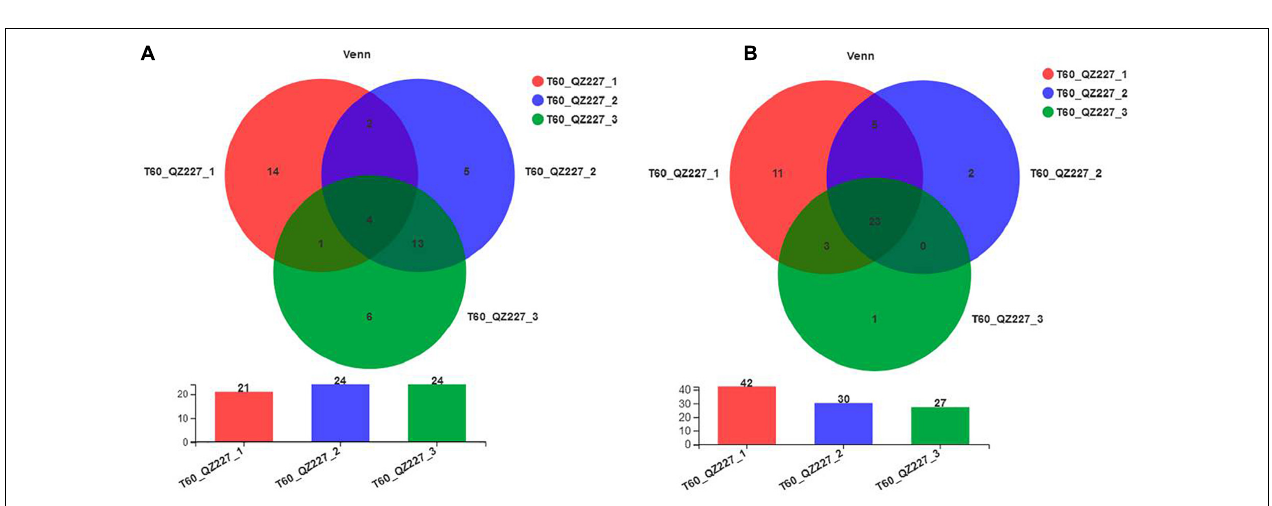
FIGURE 9 | Bacterial (A) and fungal (B) species in the paralleled QZ227 groups at day 60. The numbers in the overlapped areas represent the number of genera common to multiple groups and the numbers in the non-overlapped areas represent the number of genera unique to the corresponding group.